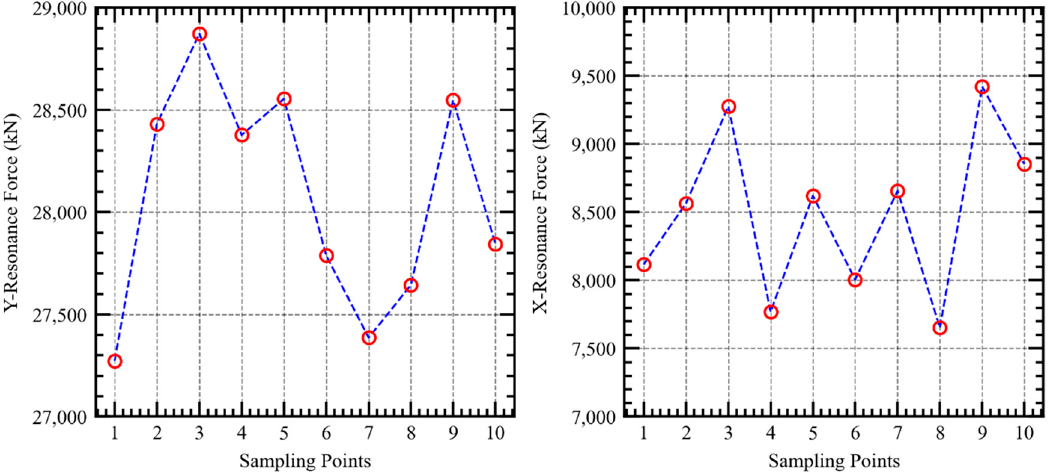
Figure 14. Along-wind and across-wind loads.